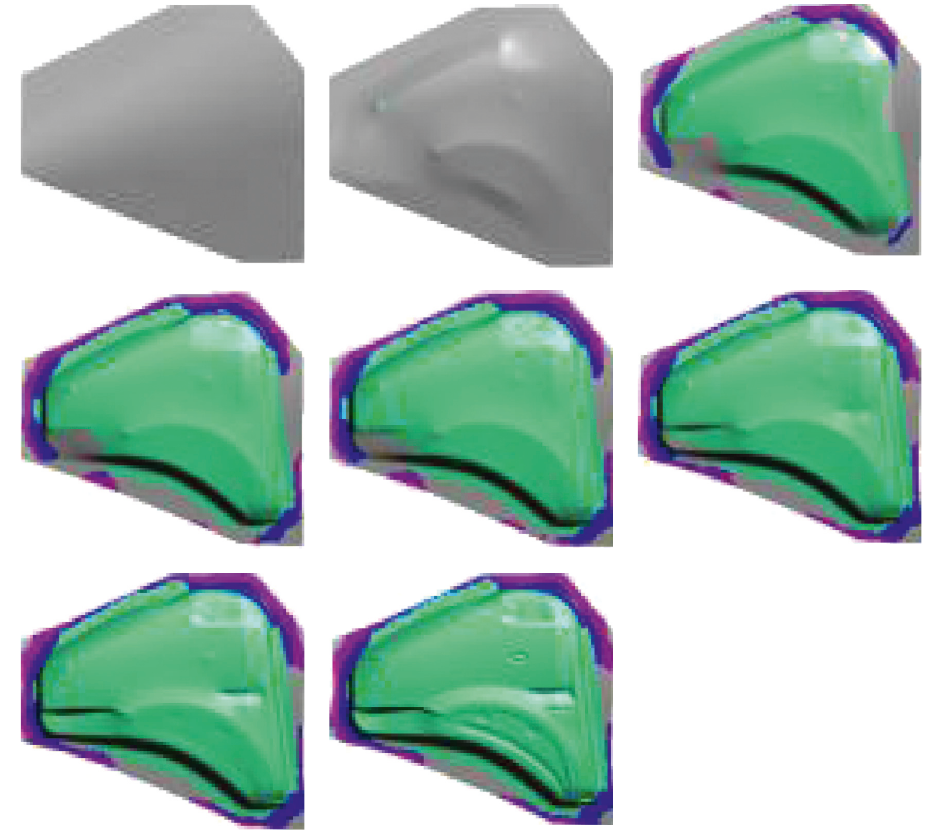
Figure 7: Fender forming process.